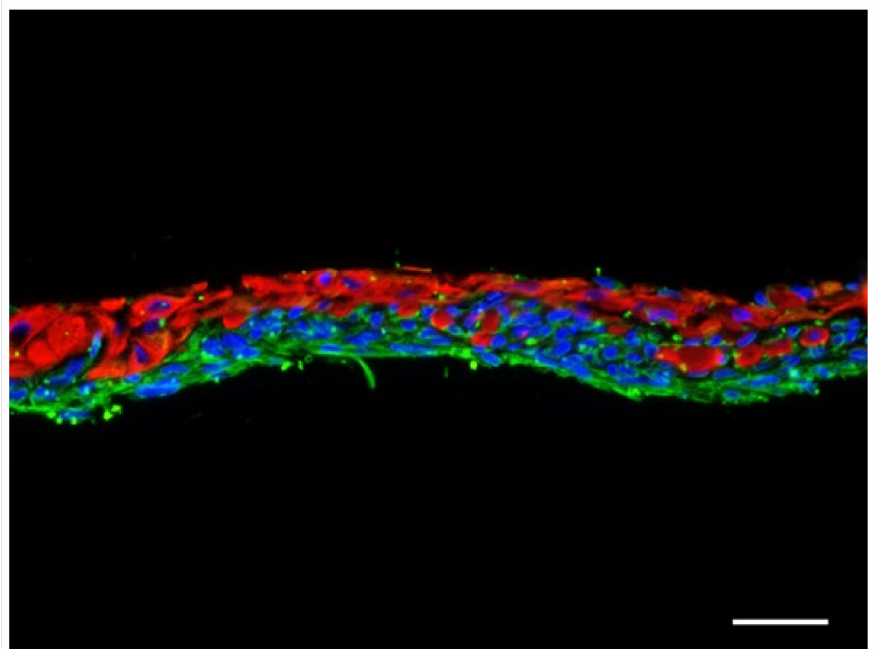
Figure 2. Immunofluorescence study of skin hydrogels fabricated in vitro after 7 days of air-liquid culture. Continuous keratinocyte layer (in red, excitation/emission: 480/527, labelled with anti- human high molecular weight cytokeratin antibody) firmly attached to the underlying fibroblasts- containing hydrogel. Fibroblasts (in green, excitation/emission: 360/470, labelled with anti-vimentin antibody) grew homogeneously across the dermal layer. Scale bar: 50 µ